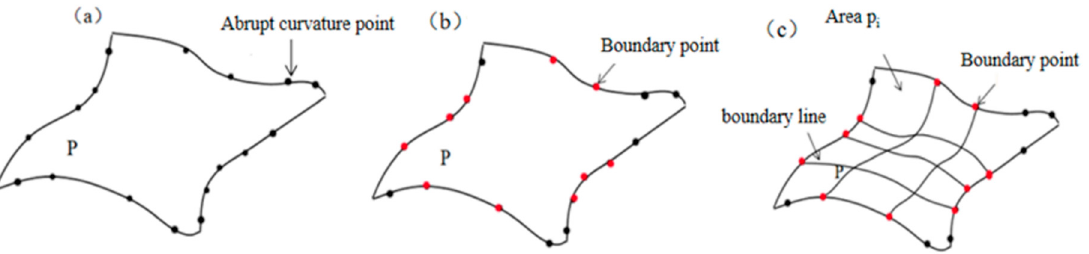
Figure 1. Selection of boundary points and region division of surfaces: ( a ) distribution of abrupt curvature points, ( b ) selection of boundary points, ( c ) surface region division.